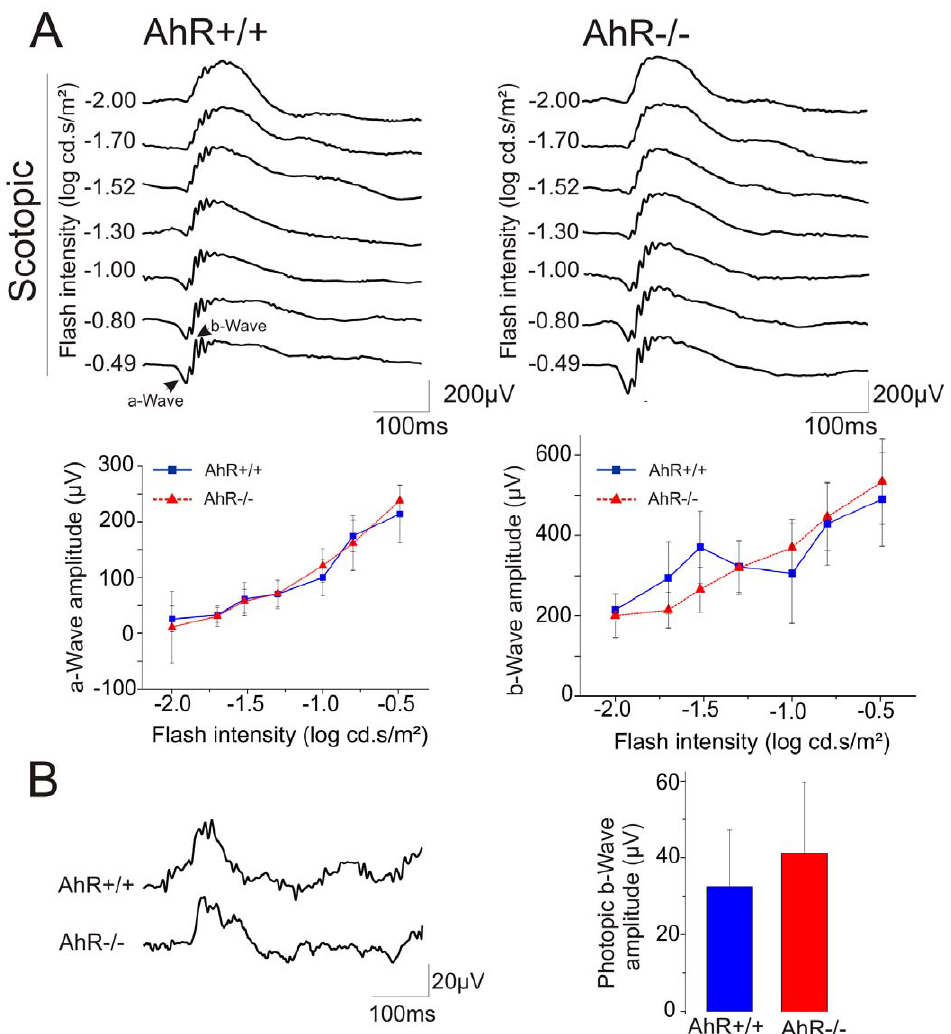
Figure 7. Electroretinograms are normal in AhR 2 / 2 mice. (A) Representative scotopic ERG at different light intensities (from 2 2 to 2 0.49 log cd.s/m 2 ) in both AhR + / + and AhR 2 / 2 mice. Quantifications of a-Wave and b-Wave amplitudes are represented in the lower panel. (B) Representative photopic ERG. The photopic response is obtained using a flash intensity to 2 0.49 log cd.s/m 2 on light-adapted mice and measured for both mice. There are no significant differences between both genotypes in scotopic and photopic ERG. Blue lines correspond to the AhR + / + mice, and red lines correspond to the AhR 2 / 2 mice.